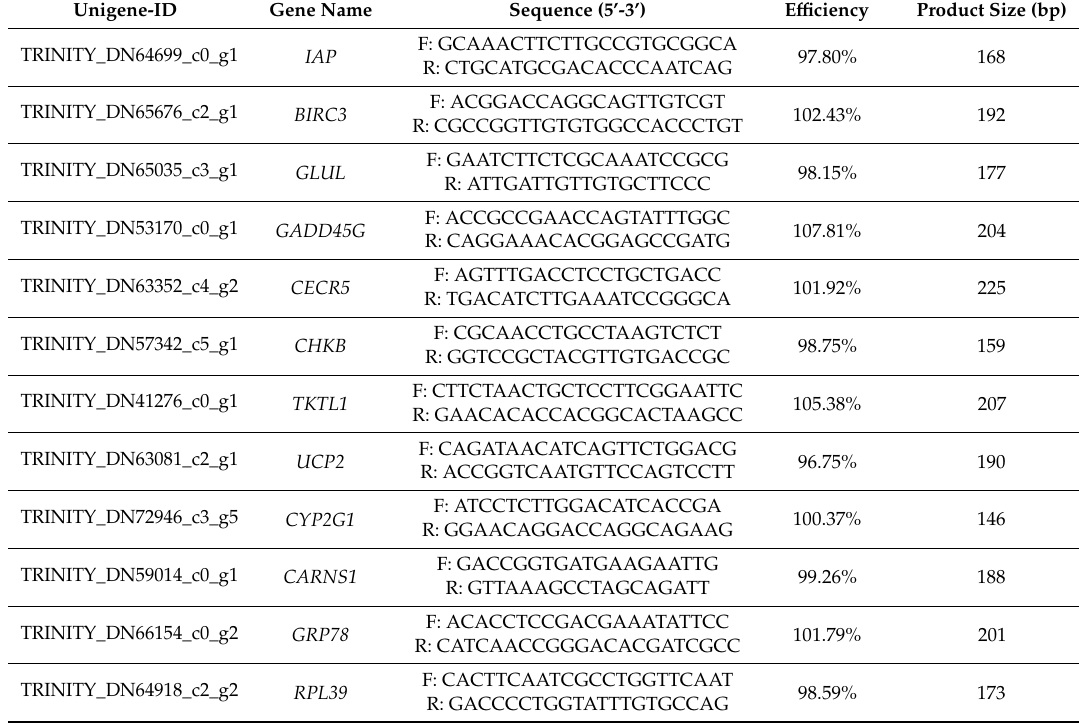
Table 6. Oligonucleotide primers designed for qRT-PCR of twelve candidate DEGs.